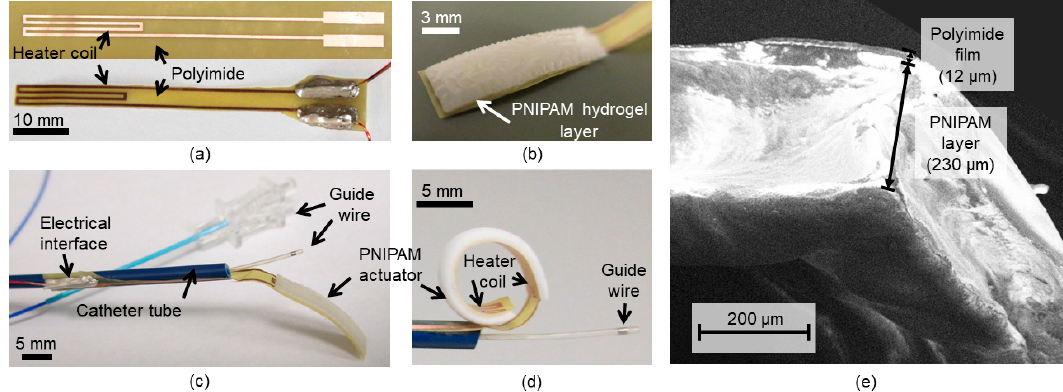
Figure 4. Optical images of fabrication results: ( a ) (Upper) flexible strip of the tip device showing the patterned heater element, and (Bottom) the shaped tip device with electrical interface (copper wires bonded to the contact pads); ( b ) PNIPAM layer integrated on the other side of the heater; ( c ) active tip device assembled on a commercial catheter tube (7.8-french Pebax ® 7233, Zeus Inc., Orangeburg, SA, USA) with a guide wire (RCF-7.0-35 check Flo Introducer, Cook Medical, Bloomington, IN, USA) inside its channel; ( d ) final curled shape of the device tip after swelling; ( e ) Scanning electron microscope (SEM) image of the device edge (captured using Sigma 500, Zeiss Sigma, Carl Zeiss NTS Gmbh, Oberkochen, Germany).